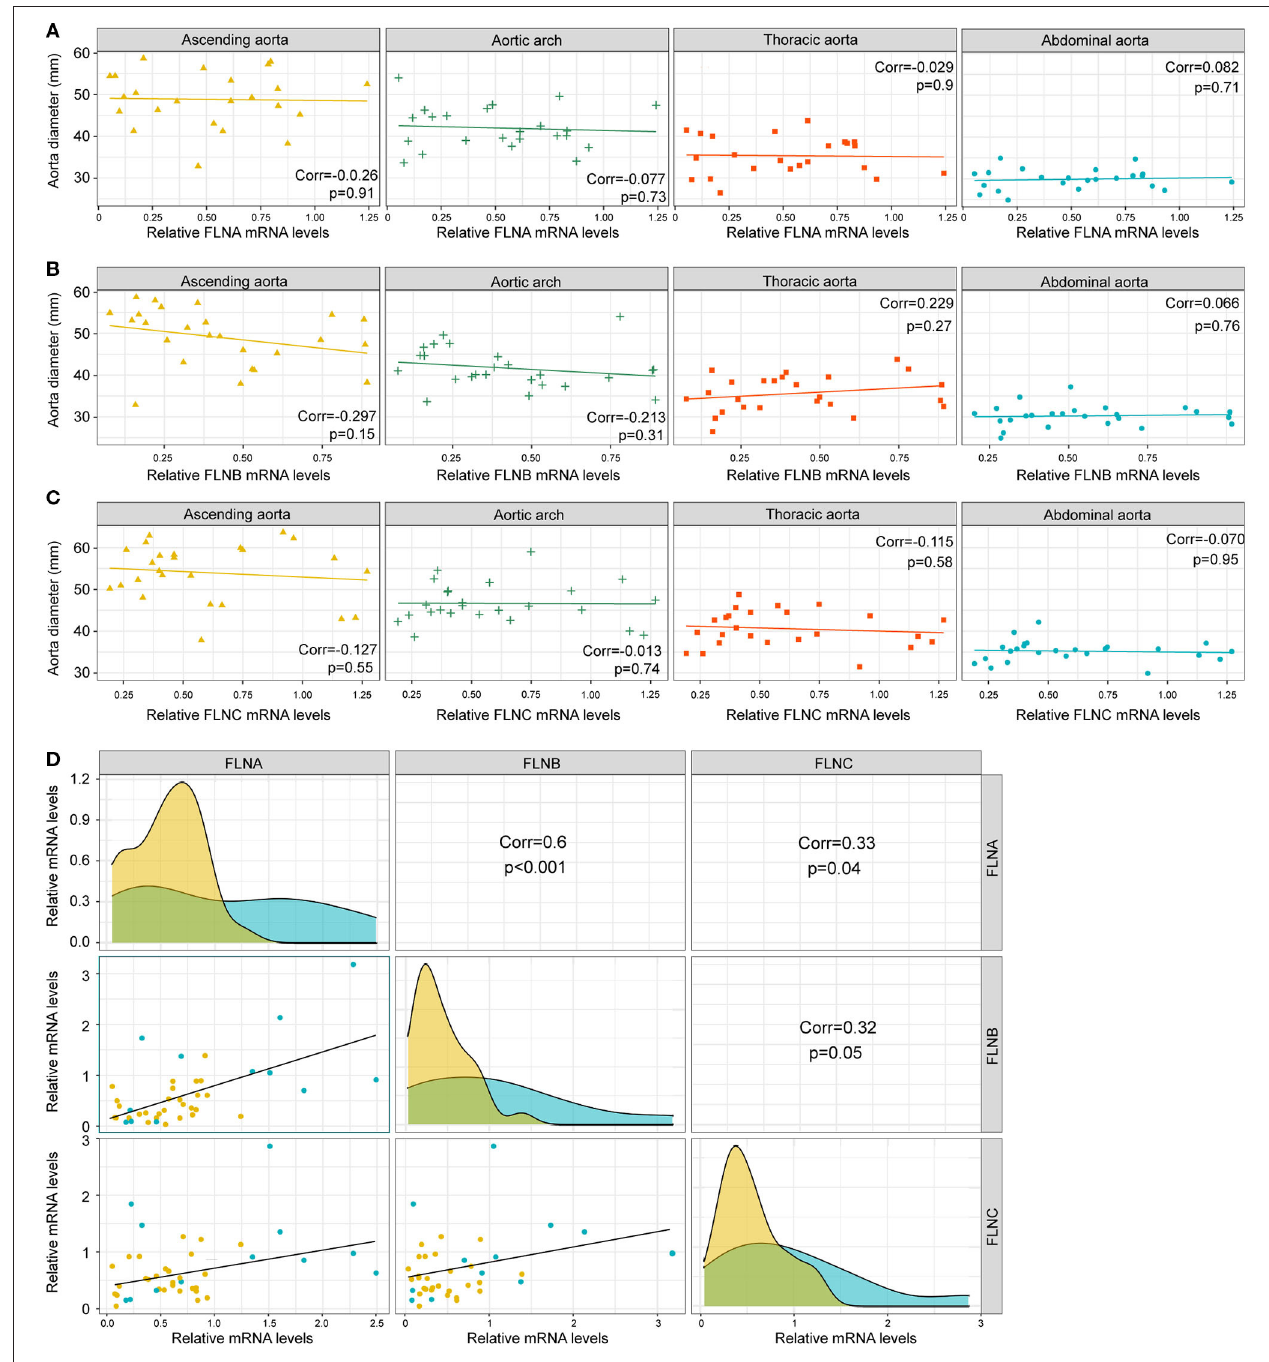
FIGURE 4 | The expression of FLNA and FLNB had a significantly positive correlation. (A–C) Correlation analysis showing the relationship between FLNA (A) FLNB (B) and FLNC (C) expression and the diameters of ascending, thoracic and abdominal aorta, as well as the aortic arch. (D) Correlation analysis showing the internal connection of mRNA levels among FLNA, FLNB, and